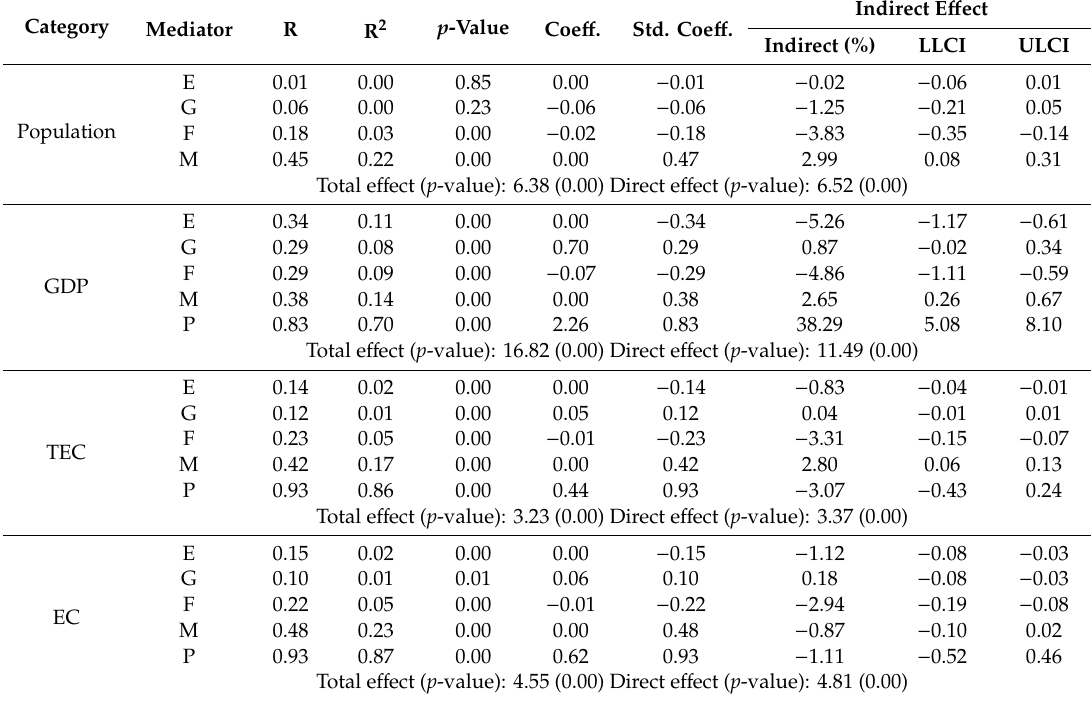
Coe ff .: coe ffi cients; Std. coe ff .: standardized coe ffi cients; LLCI: lower limit of the bootstrap confidence interval; ULCI: upper limit of the bootstrap confidence interval; P = population size; G = GDP / Population; E = TEC / GDP; M = EC / TEC; and F = F Foss /